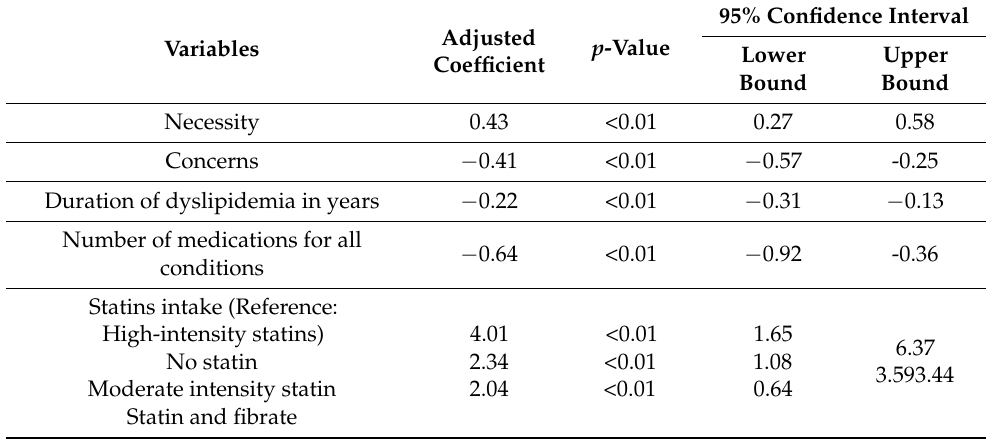
Table 3. Stepwise ordinal regression indicating variables associated with adherence